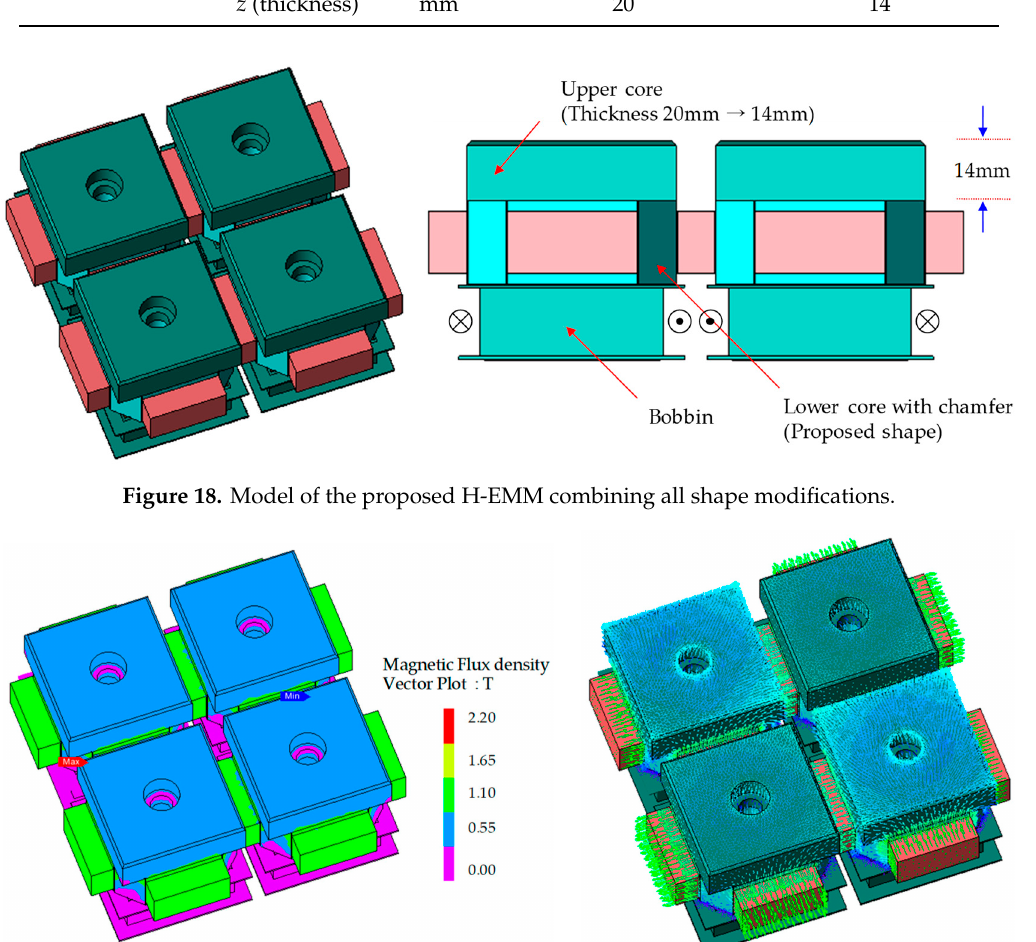
Figure 19. Magnetic flux density of the proposed model: (a) contour plots and (b) vector plots. 255 Table 4. Comparison of electromagnetic force by array quantity of basic model and proposed 256